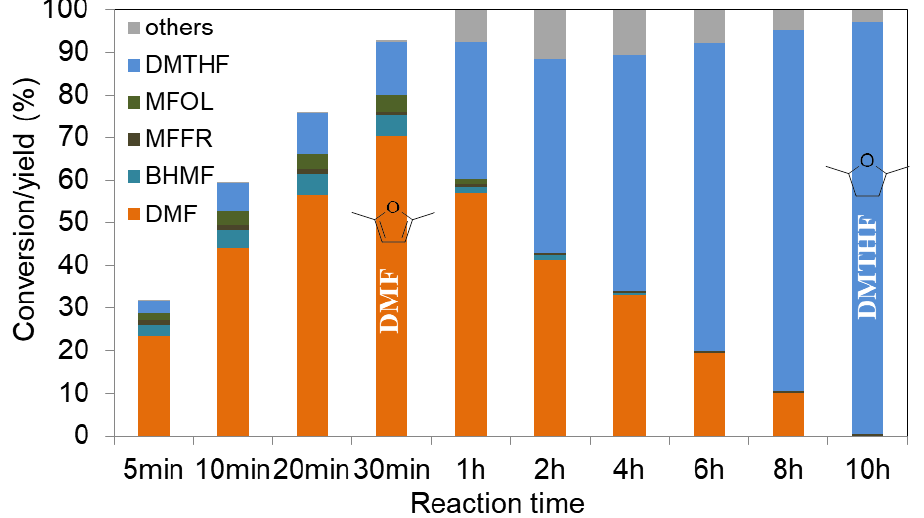
Figure 9. Evolution of HMF conversion and product yields with reaction time over Ni/SBA-15. Reaction conditions: 0.144 mmol/mL HMF in 25 mL 1,4-dioxane; P(H 2 ) = 30 bar; T = 180 ◦ C; HMF/Ni molar ratio of 3. Reprinted with permission from Ref. [60].